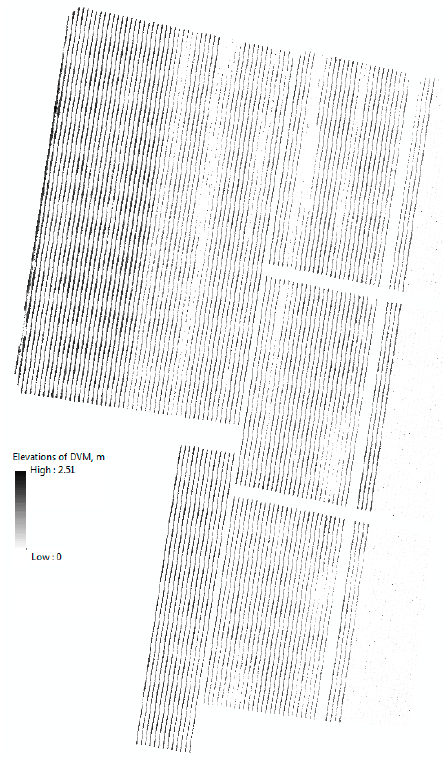
Figure 9. Result of the unbiased DVM for Site 1.